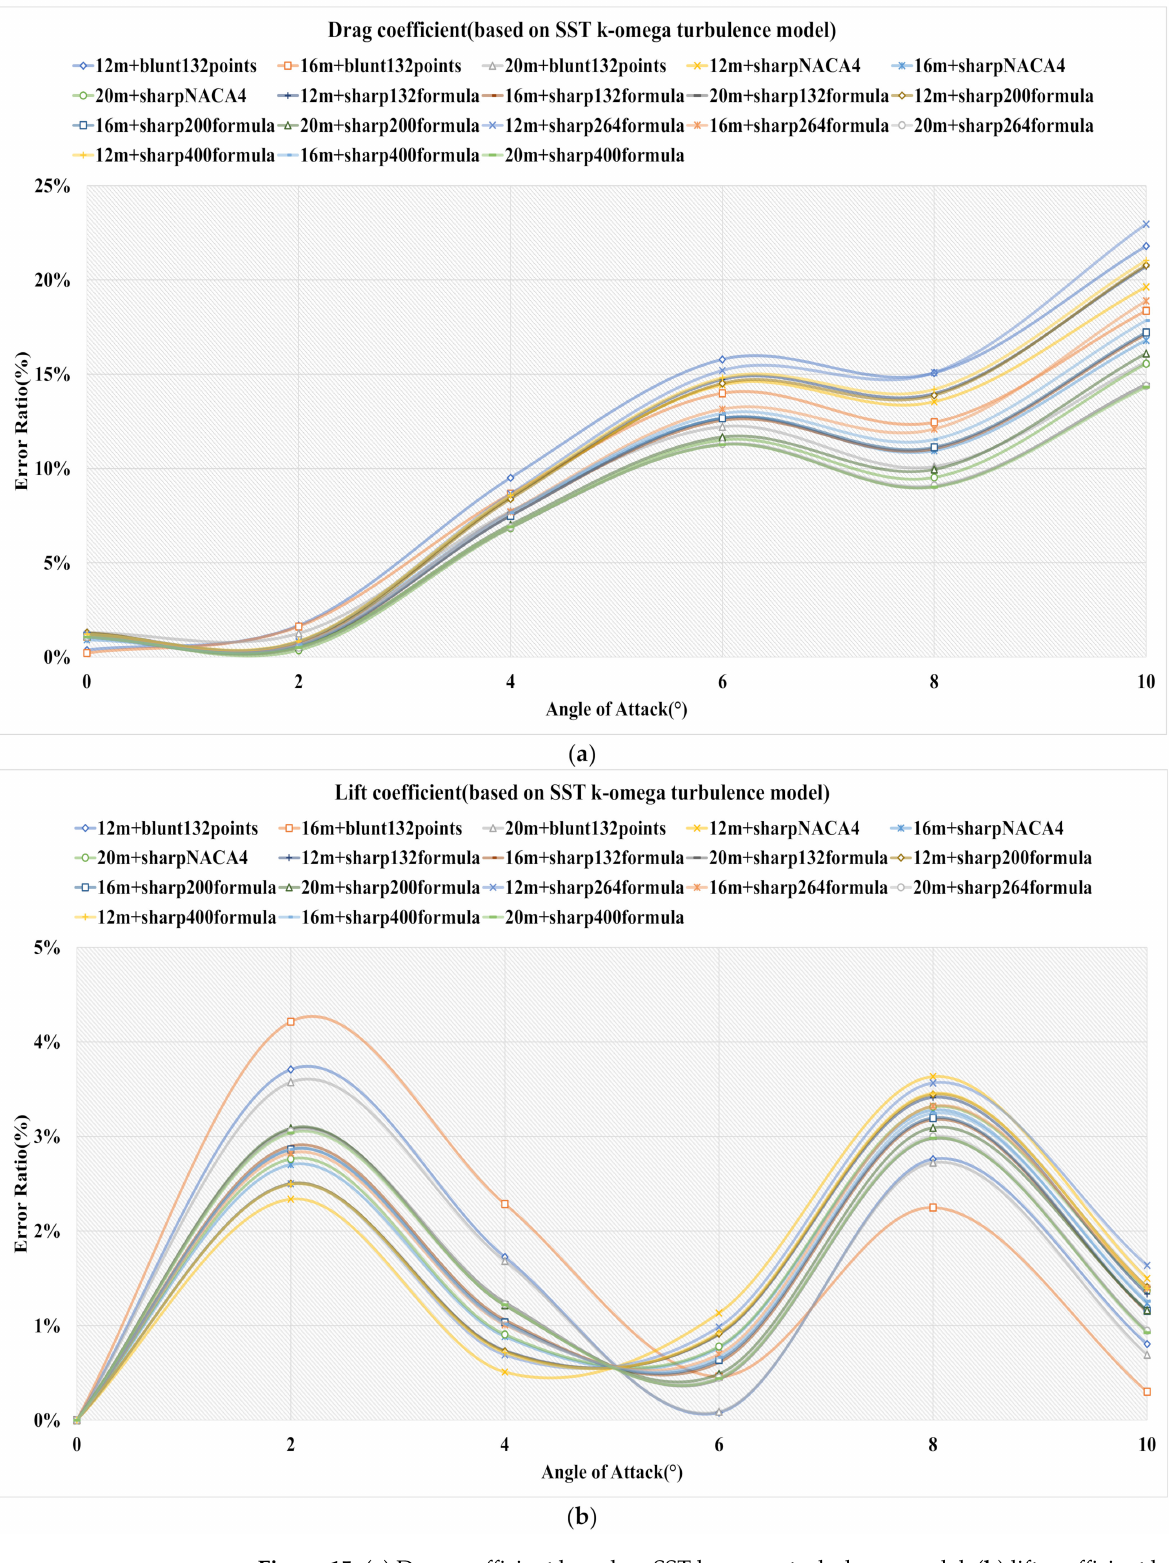
Figure 15. ( a ) Drag coefficient based on SST k-omega turbulence model; ( b ) lift coefficient based on SST k-omega turbulence